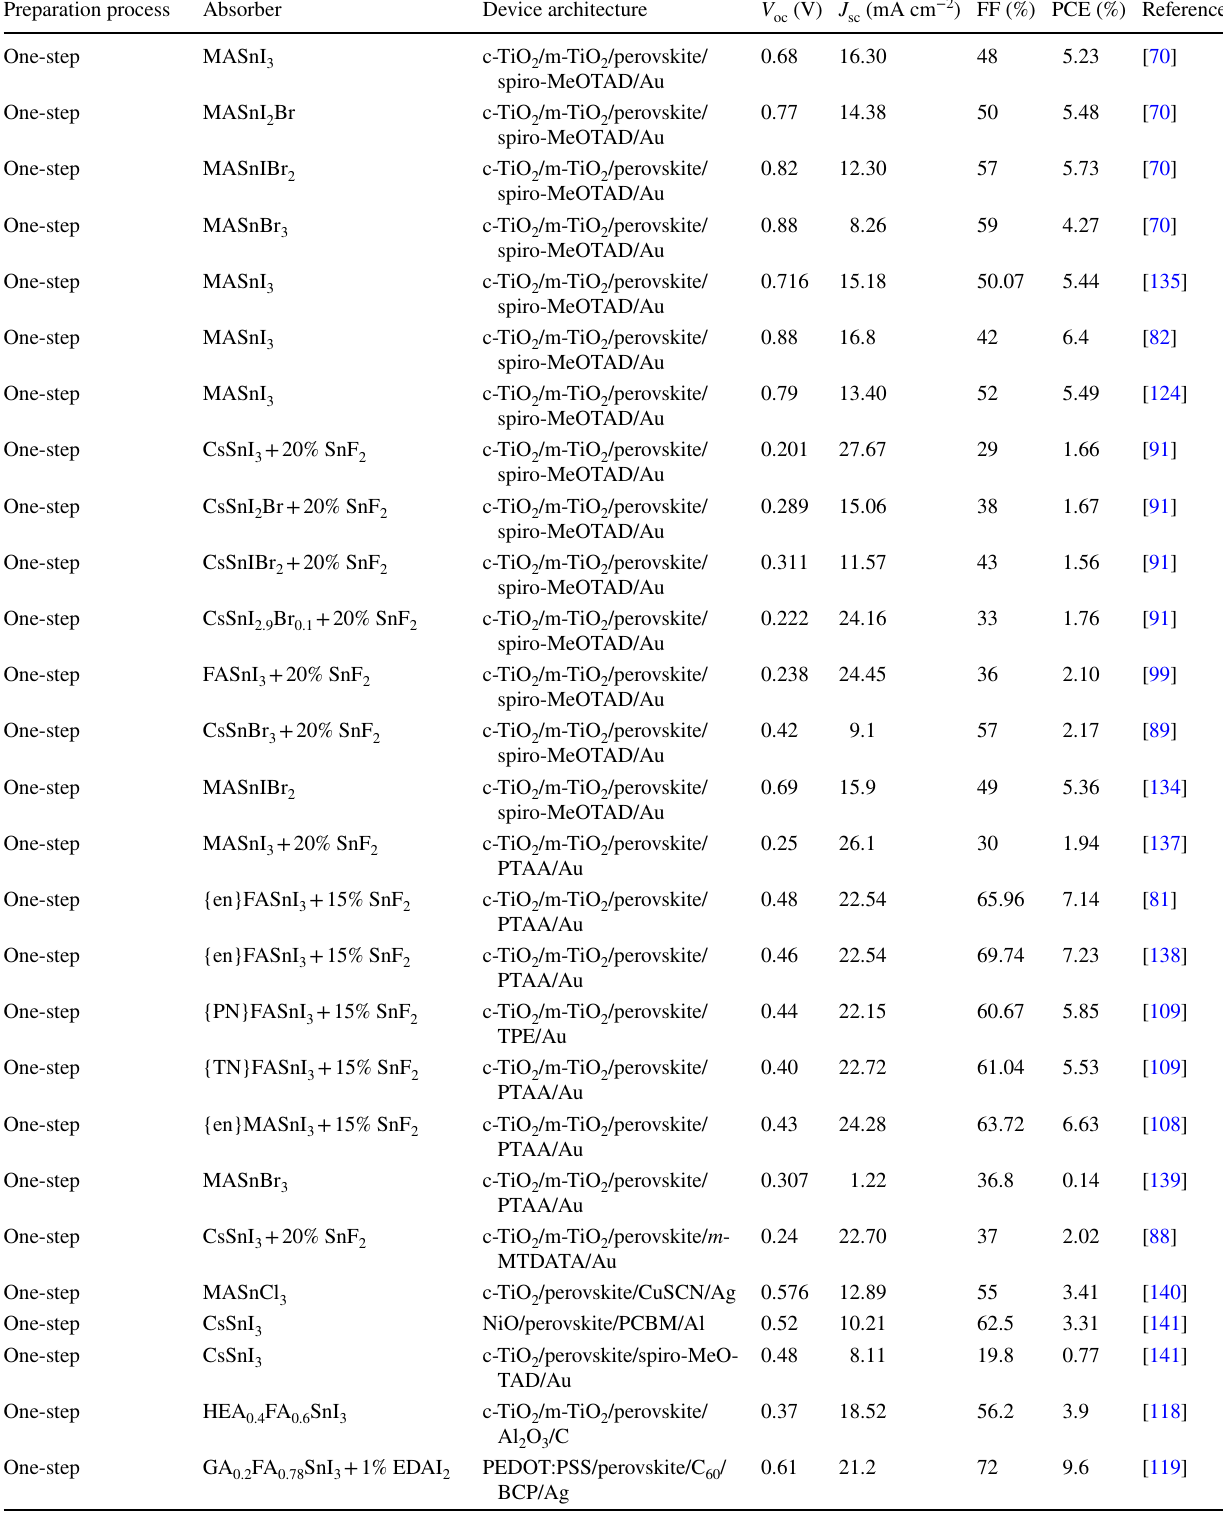
Table 1 Photovoltaic parameters of PSCs based on various Sn-based perovskite absorbers. In the table, c-TiO 2 and m-TiO 2 represent compact and mesoporous TiO 2 layer,